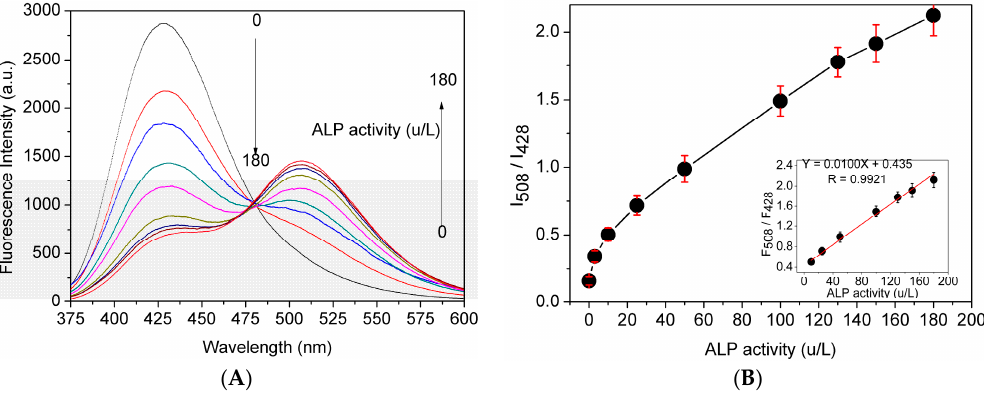
Figure 1. ( A ) Fluorescent spectra of probe 1 (10 μ M) in Tris-HCl buffer solution (pH 7.4, 10 mM) with 1% DMSO in the presence of different concentrations of ALP (0–180 U/L) at 37 °C; and ( B ) fluorescent intensity ratio (I 508 /I 428 ) as a function of ALP level, insert: the linearity of fluorescent intensity ratio (I 508 /I 428 ) as a function of ALP level, λ Ex = 360 nm.